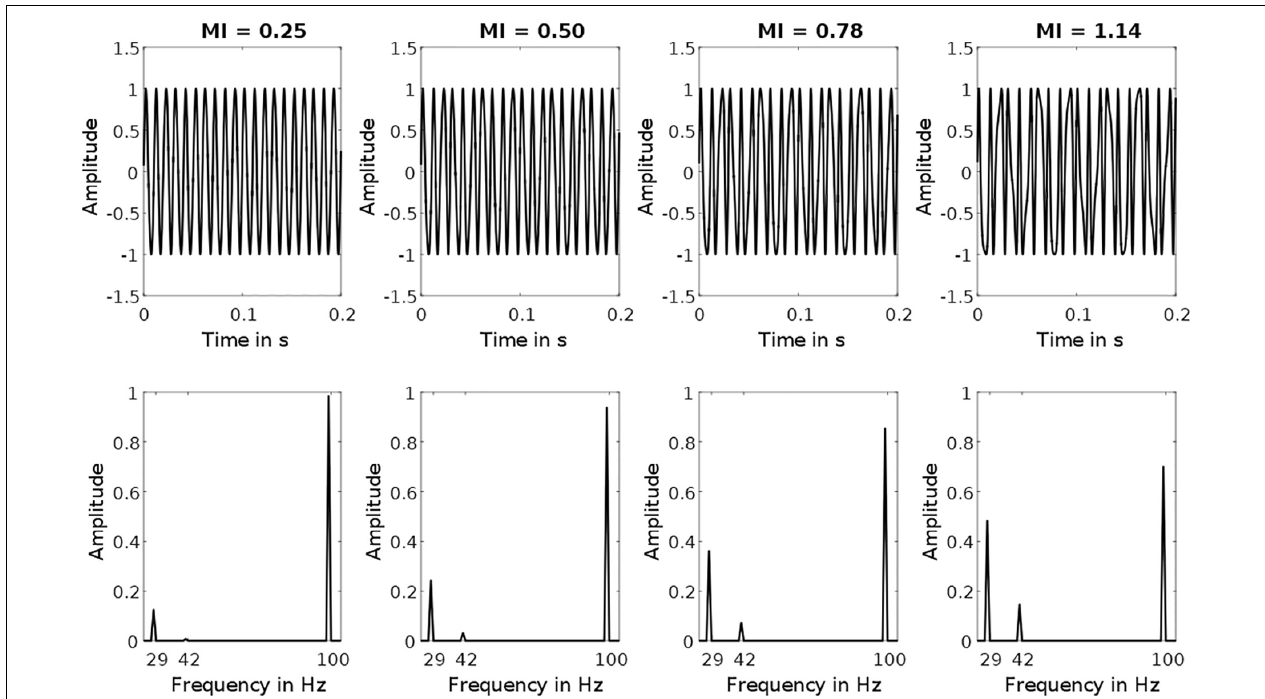
FIGURE 1 | Exemplary Stimulation Signals. Top row depicts frequency-modulated signals with a carrier frequency of 100 Hz and a modulation frequency of 71 Hz. Bottom row depicts the corresponding amplitude spectra. Each column depicts a signal with one of the four different modulation indices used. Note that target frequency amplitudes at 29 Hz increase with increasing modulation indices (from left to right: 0.12, 0.24, 0.36,